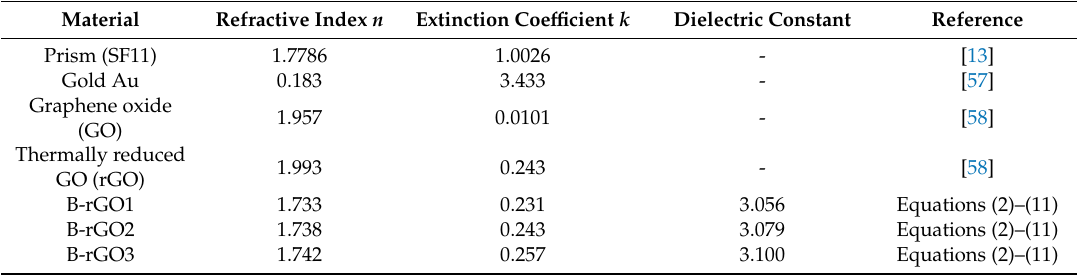
Table 3. The optical constants values for the GO, rGO, and B-rGO samples at 633